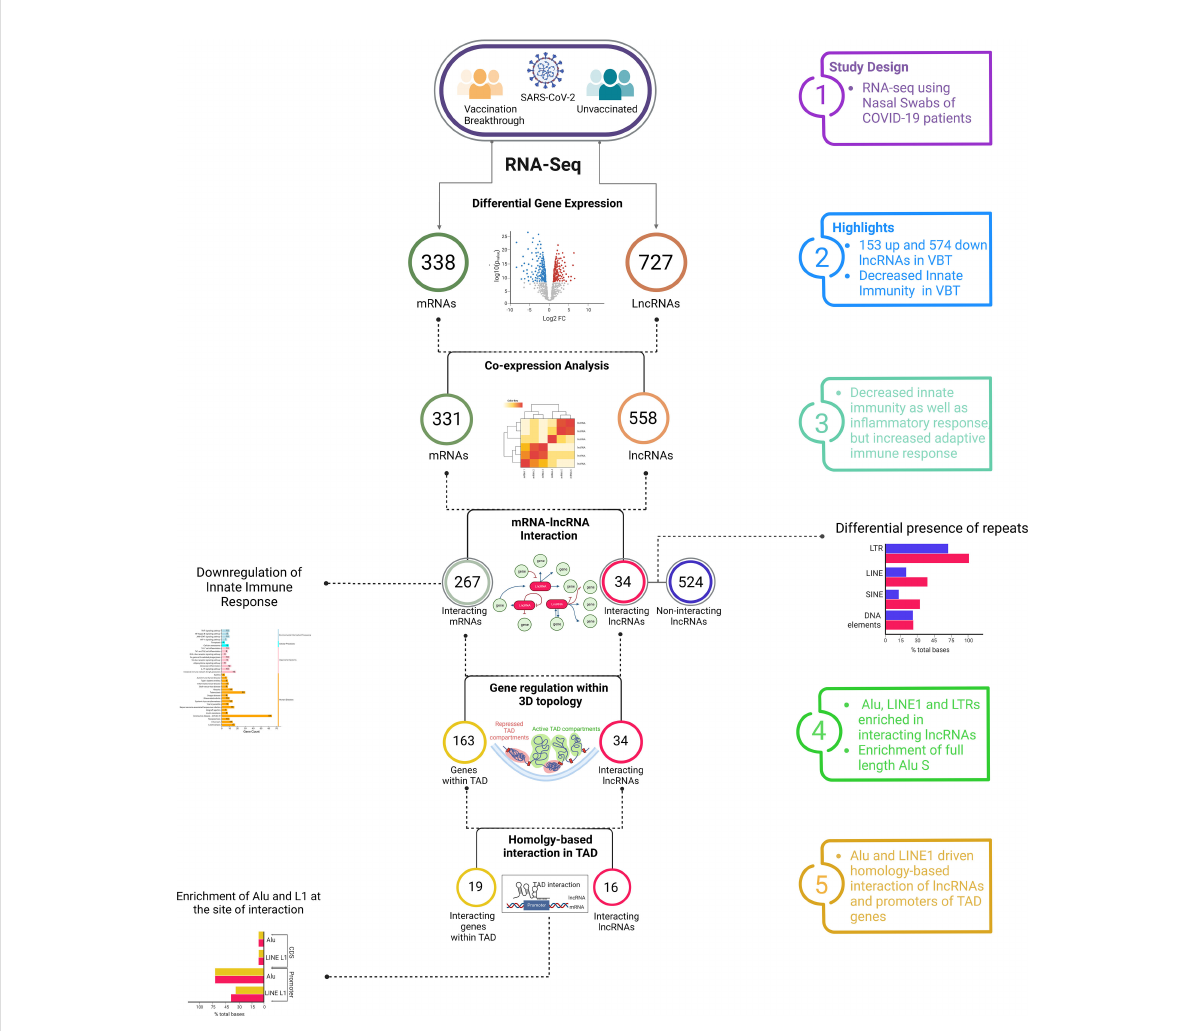
FIGURE 5 Summary of the fi ndings threading together the hierarchical inferences for vaccination breakthrough SARS-CoV-2 infections. Through a series of inter- connected and combinatorial analysis, the fi ndings highlight the functional role of lncRNAs in the VBT, albeit with milder disease